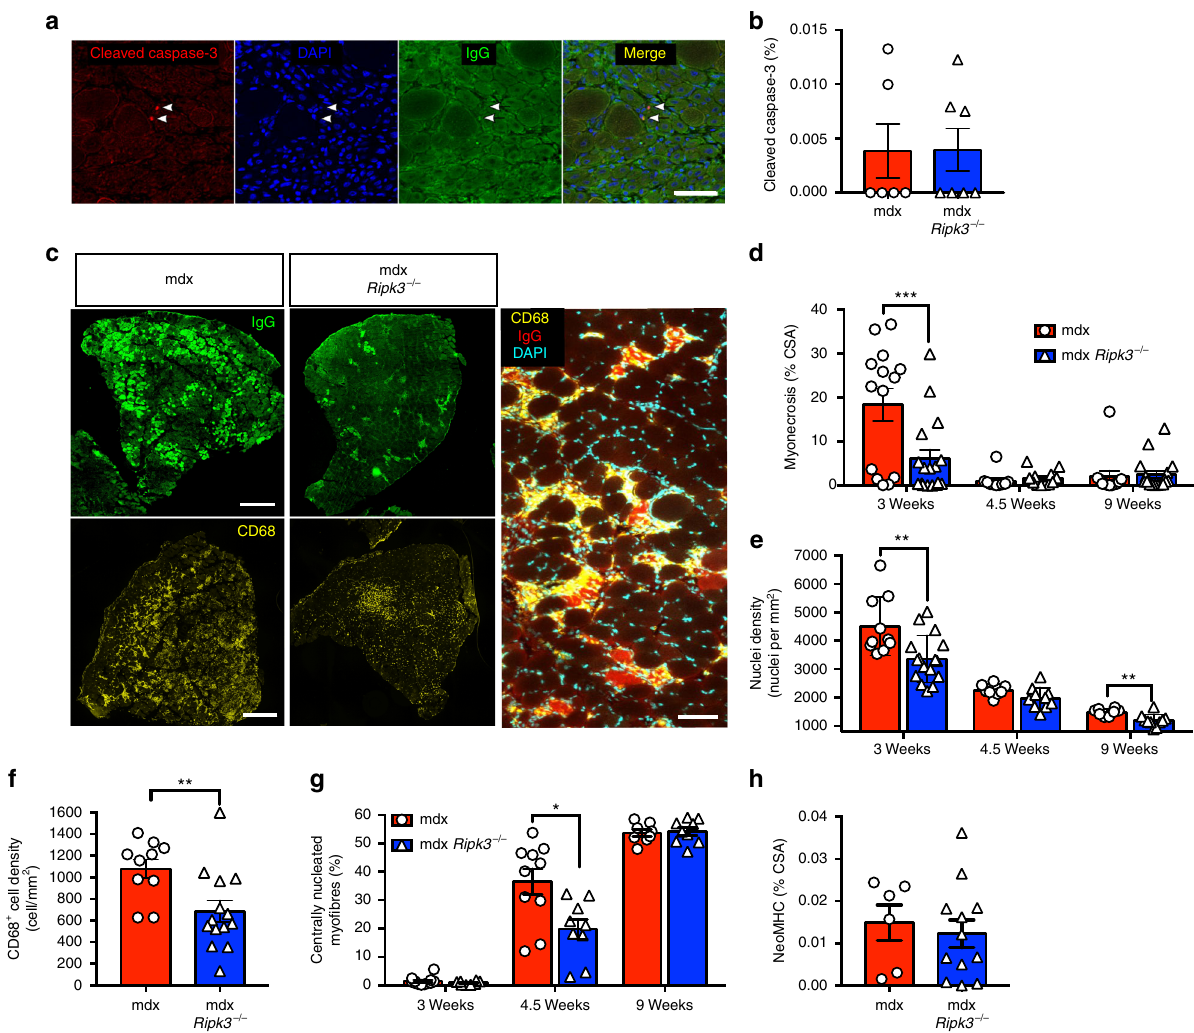
Fig. 3 RIPK3 de fi ciency reduces the acute phase of myonecrosis in mdx mice. a Representative images of cleaved caspase-3 immunolabelling in